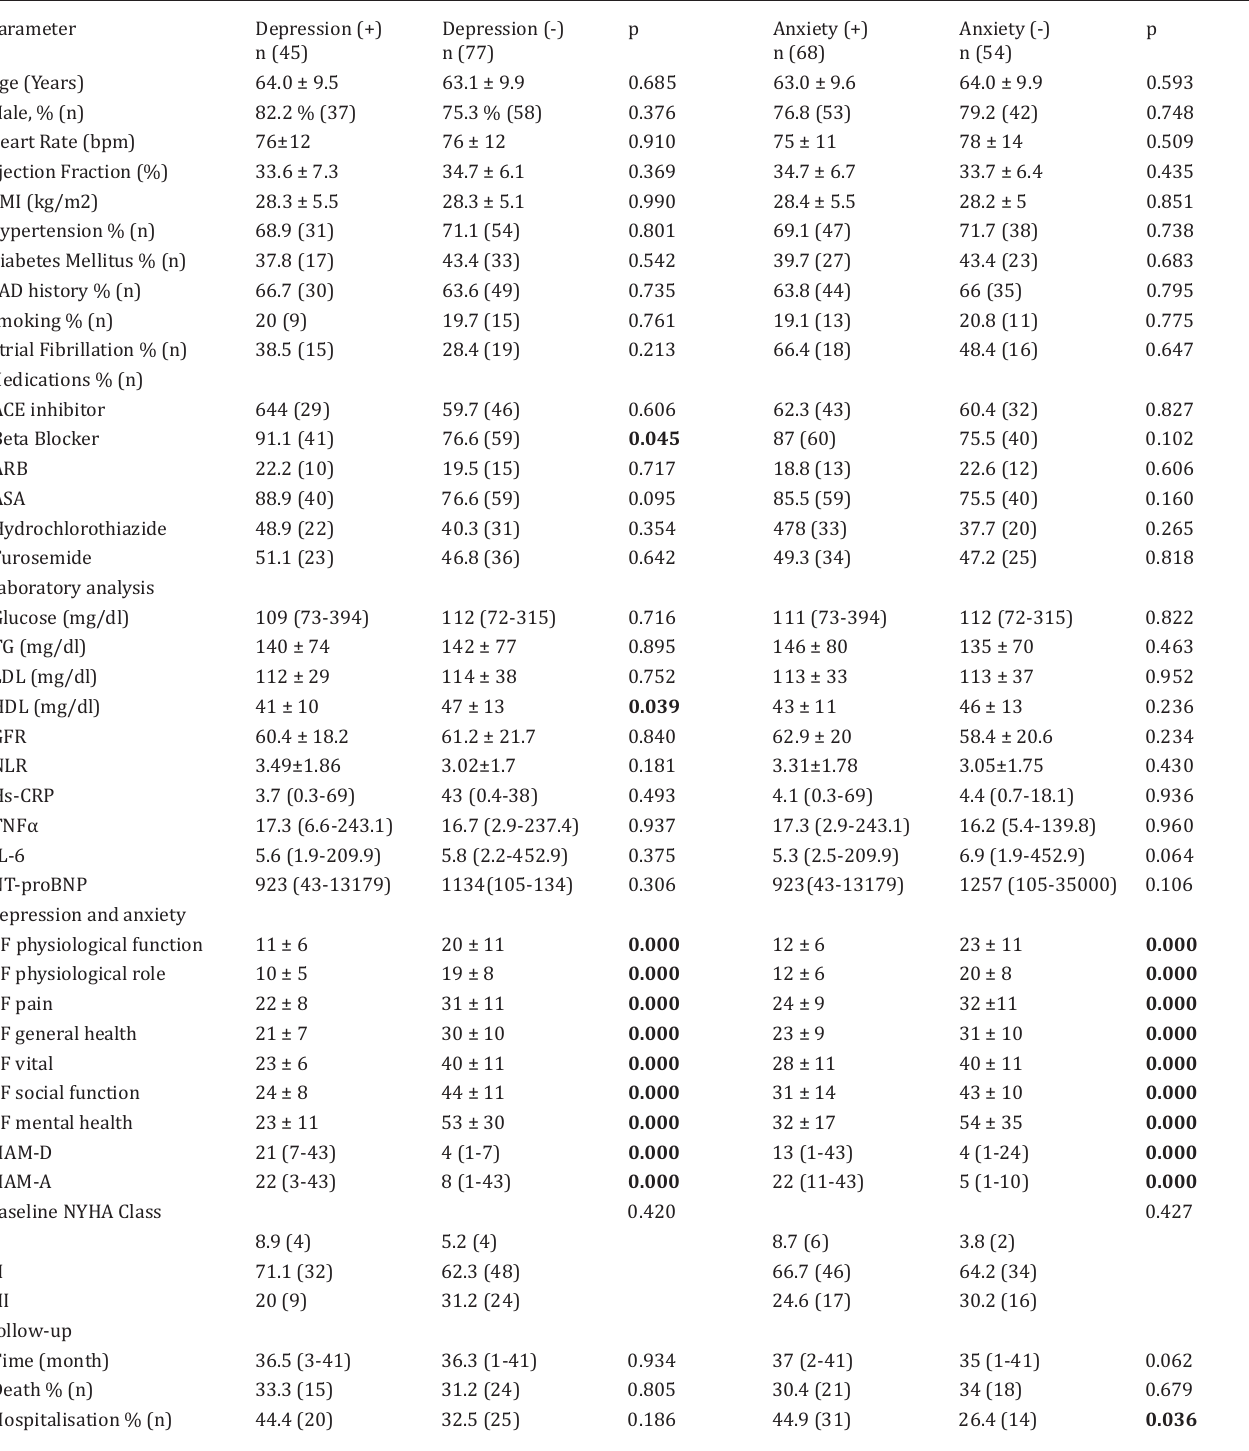
Comparisons of demographic, laboratory and psychological parameters of study